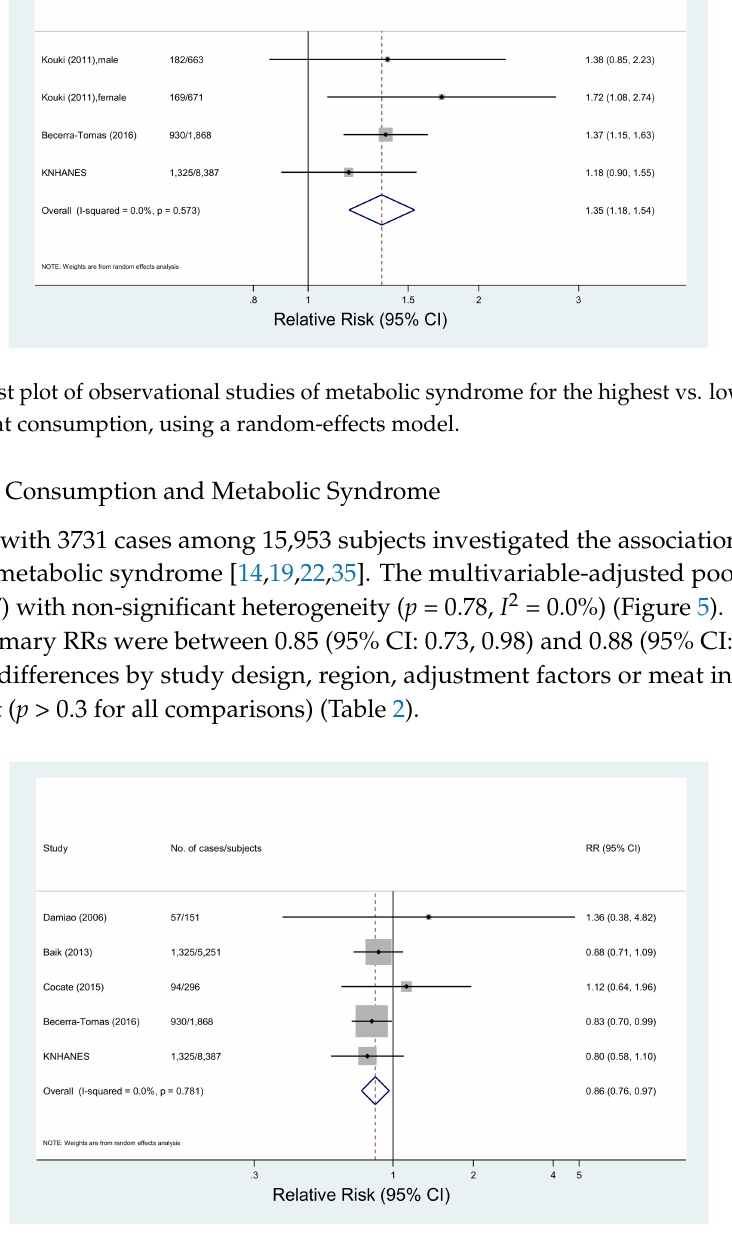
Figure 5. Forest plot of observational studies of metabolic syndrome for the highest vs. lowest levels of white meat consumption, using a random-effects